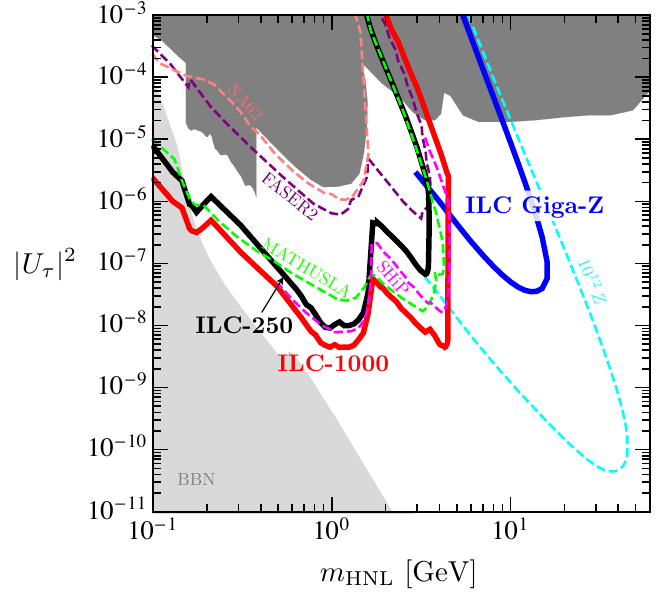
Figure 8 . Sensitivity reach of ILC beam dump experiment to HNLs mixing with the tau-neutrino in the mass and mixing plane. For the description of this plot, see the caption of figure